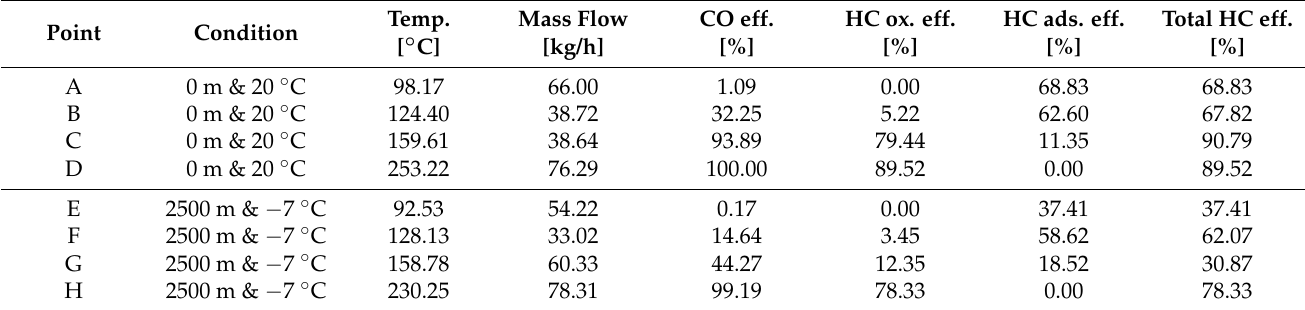
Table 5. Oxidation and adsorption conversion efficiencies at selected points.